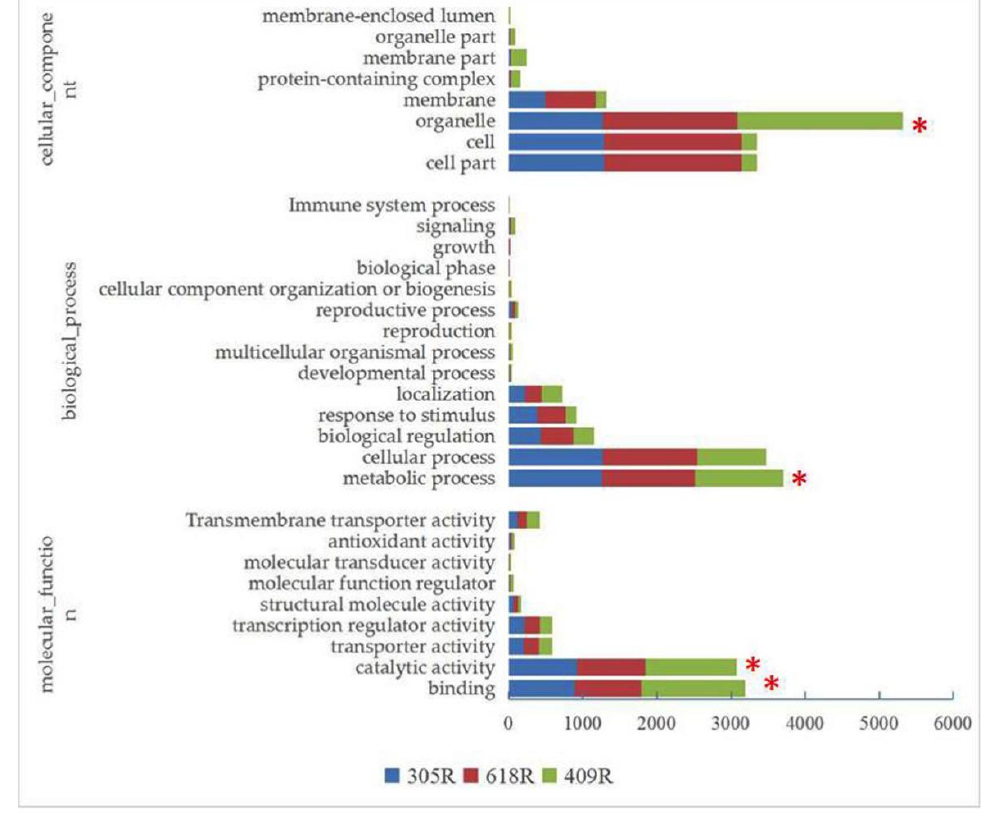
Figure 2. Gene Ontology (GO) enrichment analysis of differentially expressed genes (DEGs) in a comparison among 305R, 618R, and 409R after clubroot pathogen inoculation. “*” indicates the significant differences among three lines.